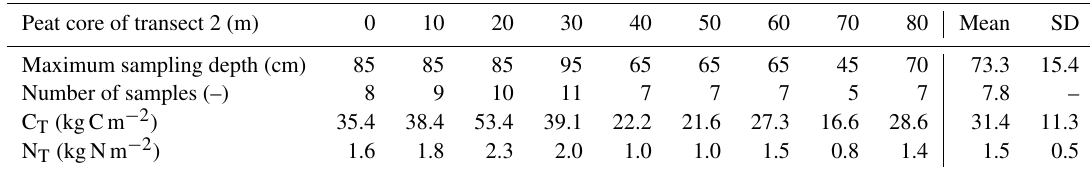
Table 4. Carbon and nitrogen stocks from peat cores along the second transect. Peat core of transect 2